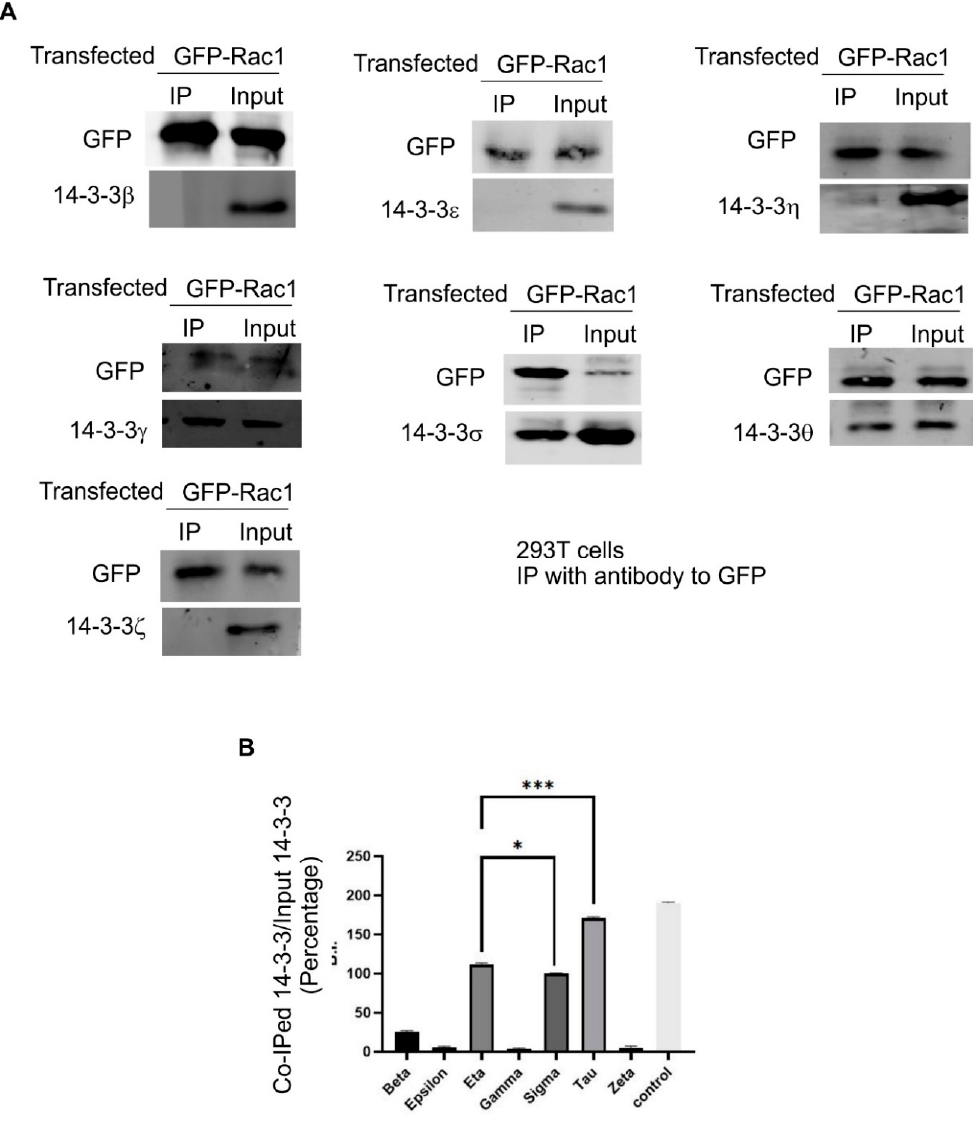
Figure 5. The interaction between Rac1 and seven 14-3-3 isoforms in 293T cells. ( A ) 293T cells were transfected with GFP-Rac1. The expressed GFP-Rac1 was IPed with the anti-GFP antibody. The co-IP of various 14-3-3 isoforms was determined by immunoblotting. ( B ) Quantification of the data in ( A ). The levels of co-IPed 14-3-3s were quantitated by densitometry. Each value is the average of at least three experiments and the error bar is standard error. * p < 0.1, *** p <